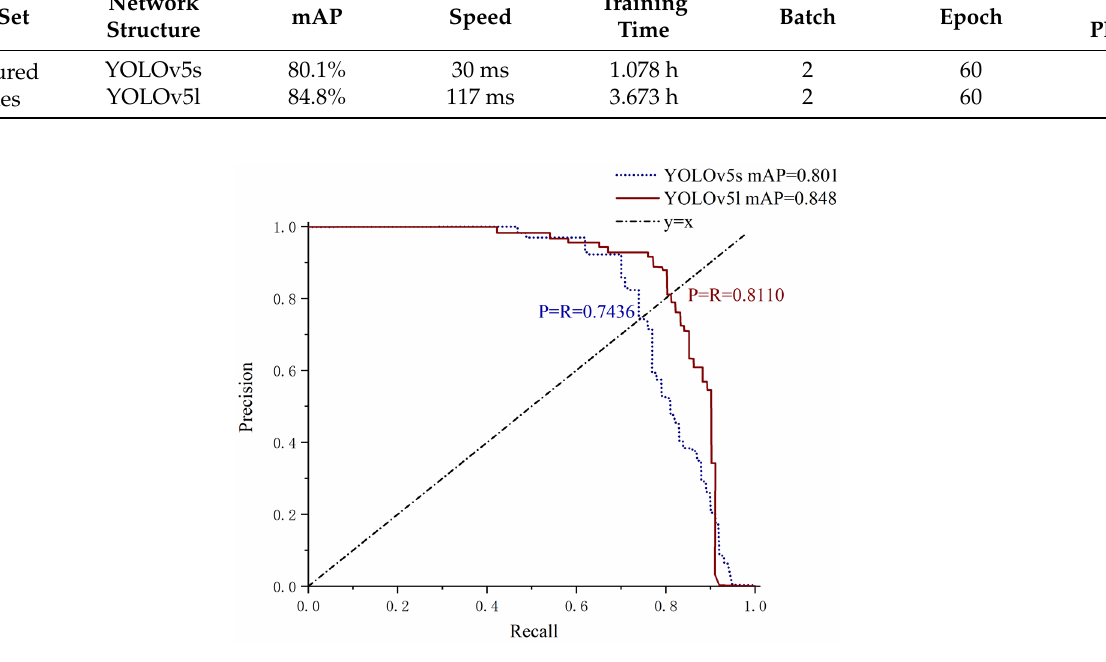
Figure 15. P-R Curve of the measured SAR Image as a test set.